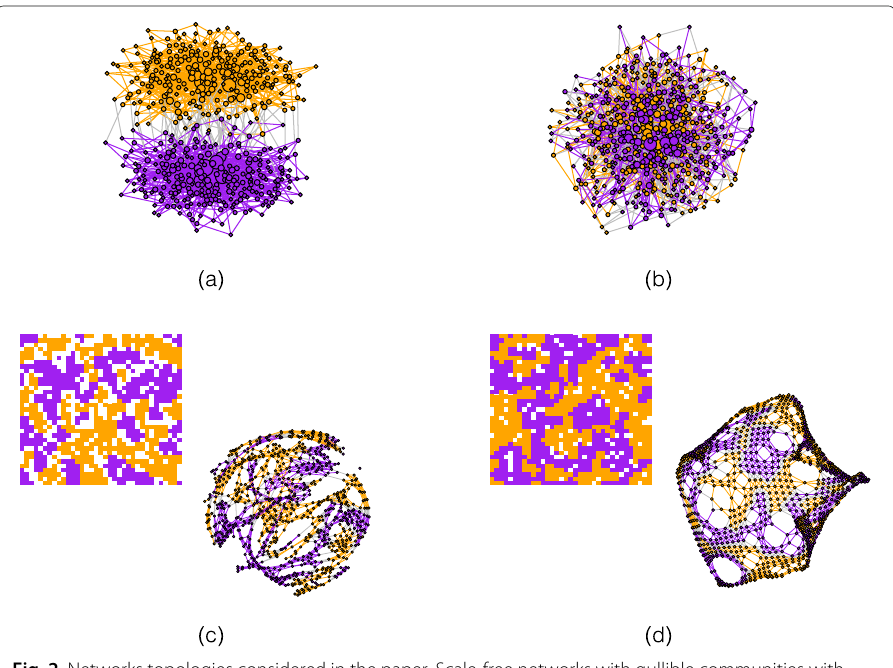
Fig. 2 Networks topologies considered in the paper. Scale-free networks with gullible communities with different values of ρ : highly segregated, with ρ = 0.05 ( a ) and well mixed, or not segregated, with ρ = 0.8 ( b ). We also show some visualizations of networks generated by means of Schelling configurations with different values of density D and preference P : D = 0.7, P = 0.5 in ( c ) and P : D = 0.9, P = 0.3 in ( d ). Different visualizations of Shelling based networks are shown to emphasize the segregation patterns within the grid, than to allow an intuitive comparison with scale-free networks with the application of a force-based layout